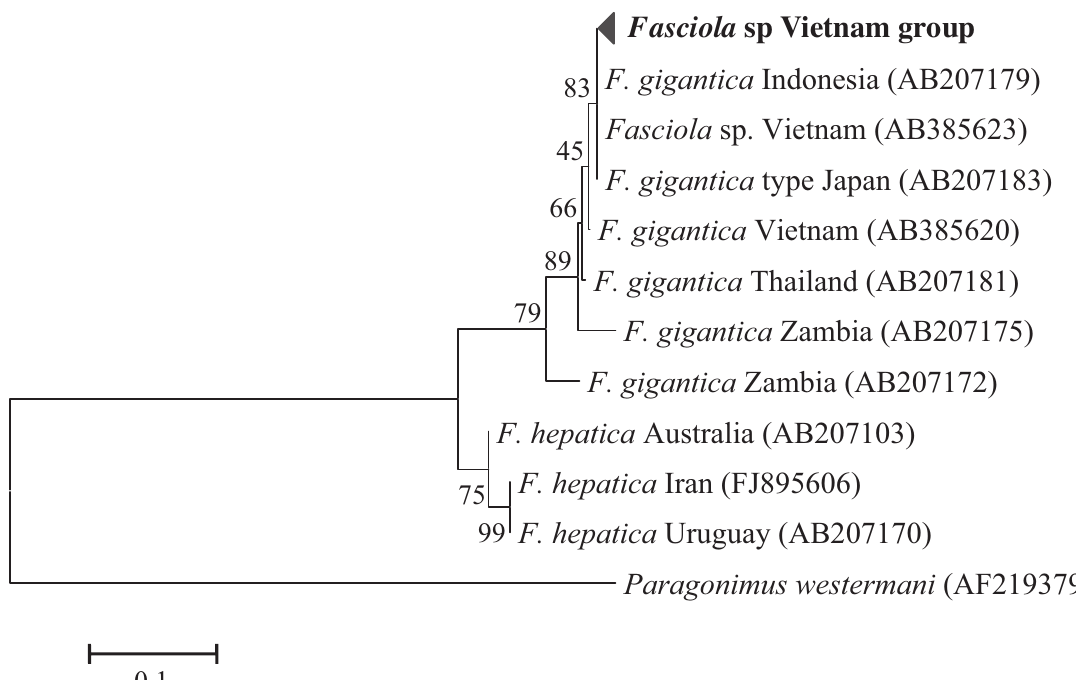
Fig. 2. – Phylogenteic relationship of Fasciola parasites based on sequences of COI. Paragonimus westermani (AF219379) was used as an outgroup. Evolutionary relationships of 12 taxa was inferred using the maximum likelihood method based on Tamura-Nei model (Tamura & Nei 1993) with Invariant sites (I). The percentage of replicate trees in which the associated taxa clustered together in the bootstrap test (2000 replicates) are shown next to the branches (Felsenstein, 1985). Phylogenetic analyses were conducted in MEGA5 (Tamura et al .,